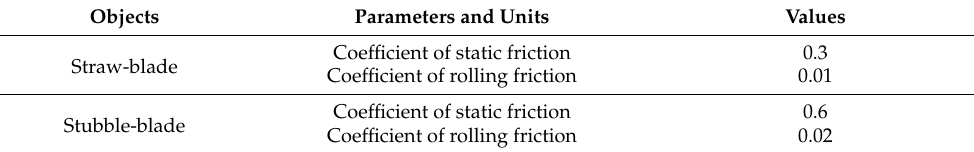
Table 1. Cont. Objects